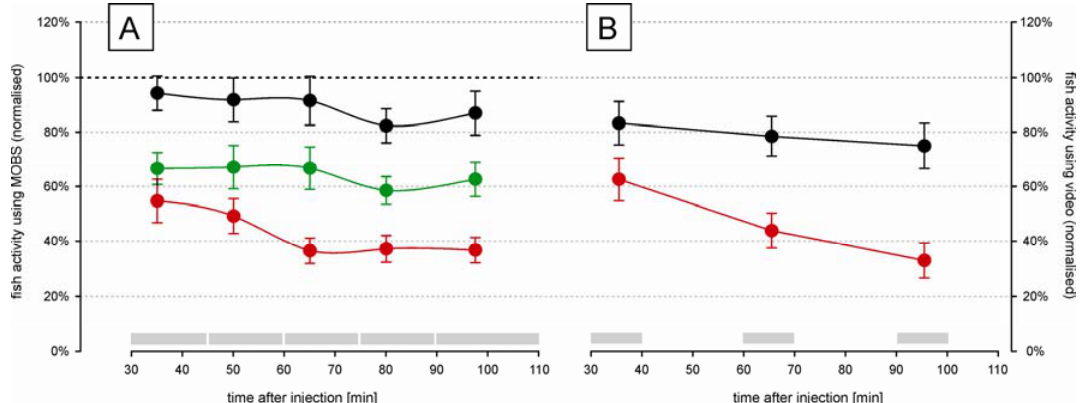
Figure 3. Time-course changes in zebrafish activity after injection of 10% acetic acid (red), 5% acetic acid (green) and control saline solution (black). Fish activity was recorded using the MOBS system (A) and by video analysis (B). All values are normalized to the median of pre-treatment activity (100%). Fish activities for periods of 15 min and 10 min (MOBS system (A) and video recording (B), respectively) are shown as Winsorized mean ± standard error, connected with a solid line. Recorded time periods are highlighted as grey bars above the time